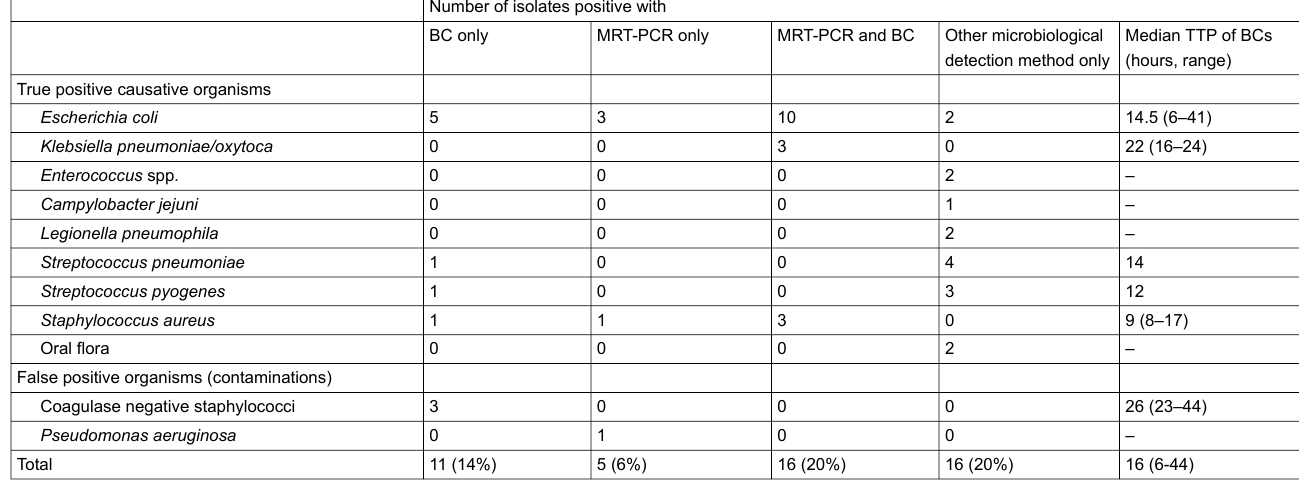
Table 2: Overview of organisms detected with multiplex real-time polymerase chain reaction (MRT-PCR), blood cultures (BC) and other microbiological methods and time to positivity (TTP) of BC in patients with bacterial sepsis (n = 79). Number of isolates positive with BC only MRT-PCR only MRT-PCR and BC Other microbiological